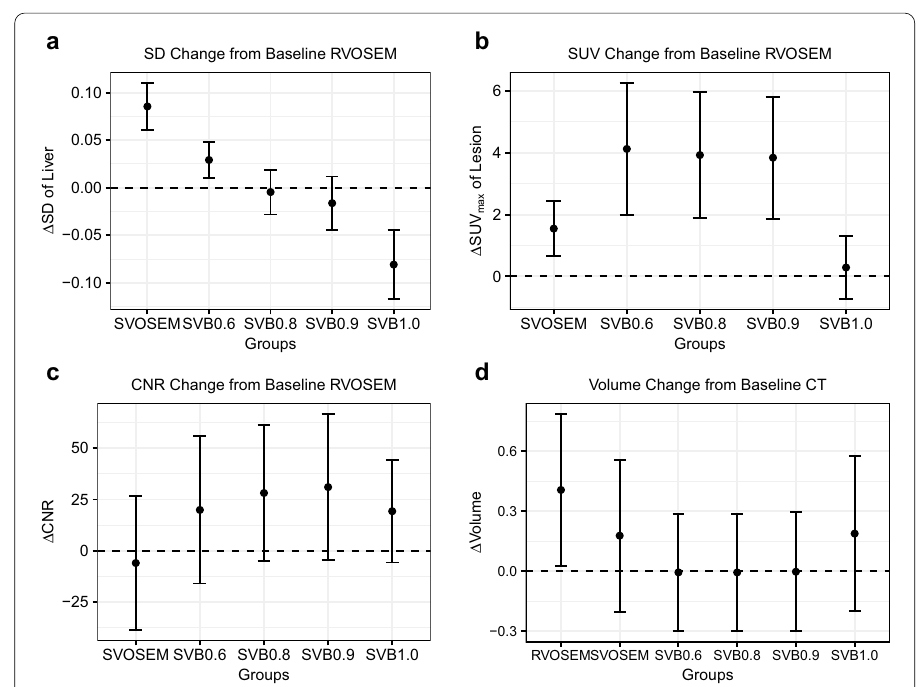
Fig. 2 Change of SD, SUV max , and CNR in SVB and SVOSEM groups from the baseline (the RVOSEM group) and PET‑derived volume change from the baseline (CT measurement) in the patient study. The difference was calculated by subtracting the value of the baseline group from each reconstruction group for every patient. The mean (dot) and standard deviation (error bar) of the difference were calculated over all patients or lesions for each metric and plotted in the figure. The baseline group was RVOSEM for calculating the difference of SD, SUV max and CNR. The baseline group was CT measurement in the calculation of the difference of the lesion